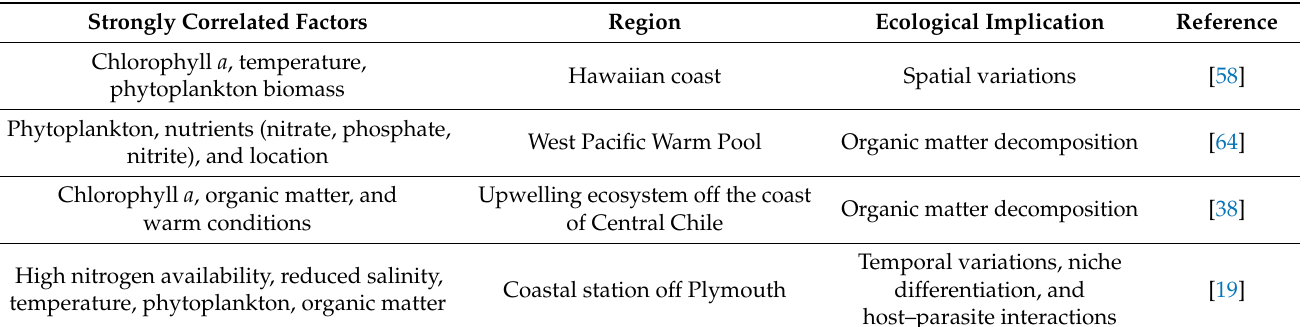
Table 3. Factors affecting fungal assemblages in water columns of different marine habitats and their ecological